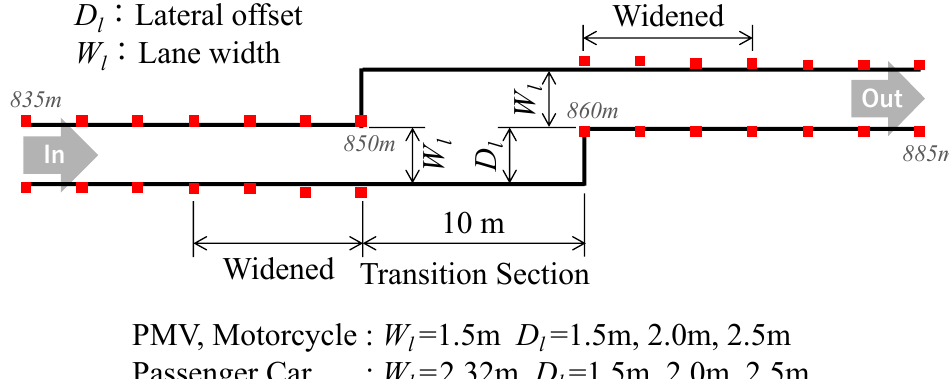
Figure 22. Three levels of severity on driving course were set by parameter